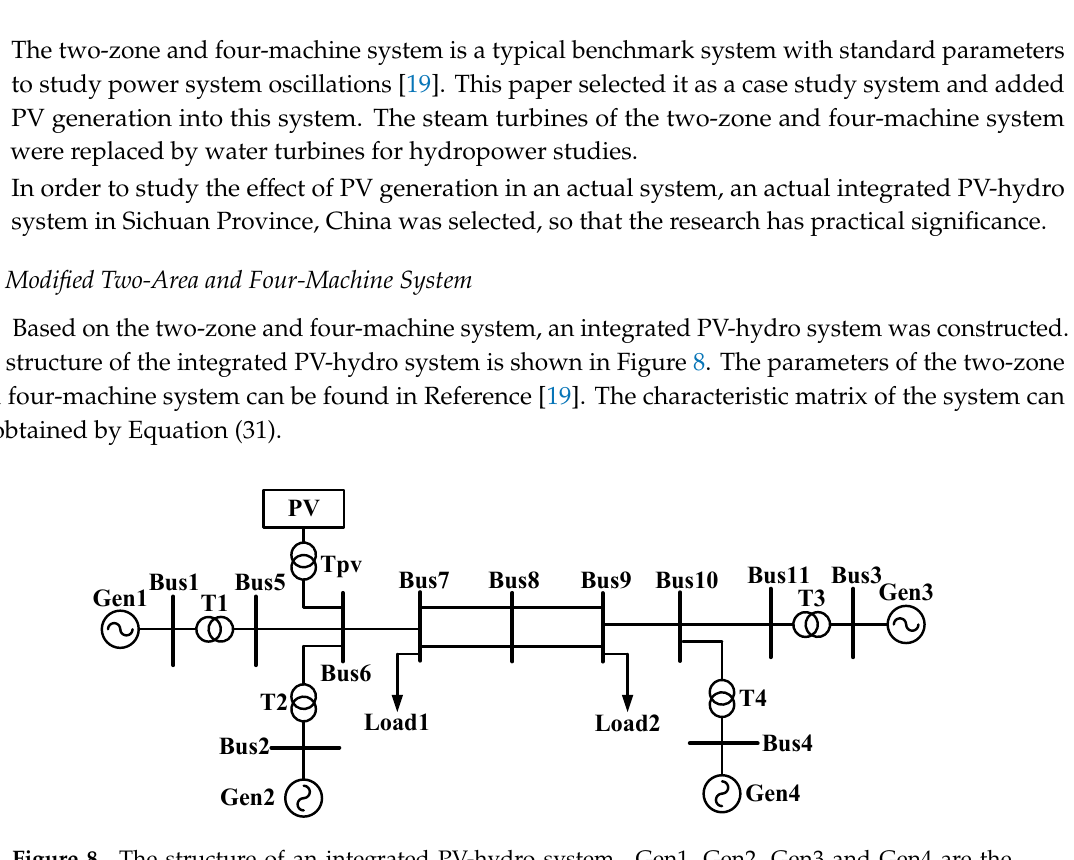
Figure 8. The structure of an integrated PV-hydro system. Gen1, Gen2, Gen3 and Gen4 are the abbreviations for the names of hydropower stations.